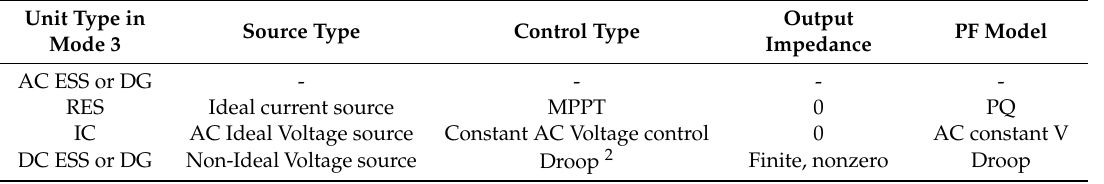
Table 2. The electrical behavior of the main components of IHMG in mode 3.